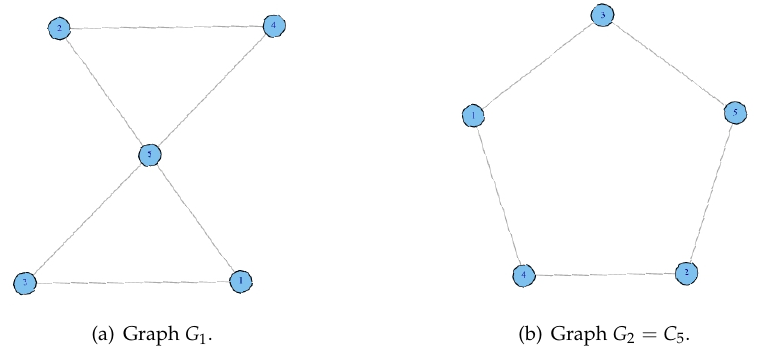
Figure 4. Two networks G 1 and G 2 = C 5 representing different styles.